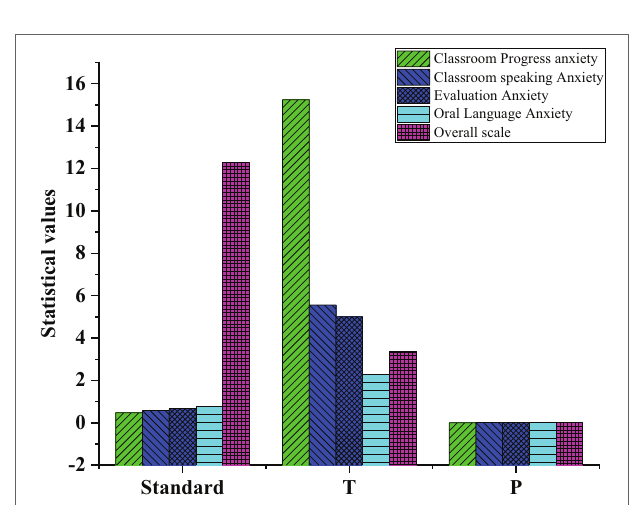
FIGURE 12 | Result chart of correlation analysis: standard stands for standard deviation; T is the T value of correlation analysis; value of p indicates the degree of